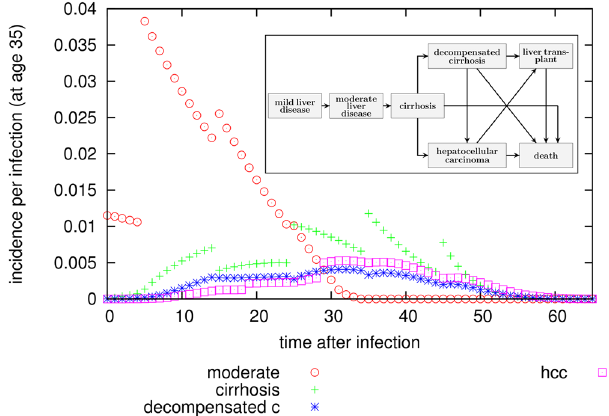
Figure 6. Probability for incidence of progression states as a function of time after infection. These probabilities are calculated separately for each infection age (in this figure this is 35 years of age), since we use age-dependent disease progression values 40 as well as mortality data 39 . From these values, cumulative incidences as a time after infection can be calculated, and from that the average number of life years lost (again as a function of time of infection), which allows to calculate an estimate on the number of life-years saved at system-level via comparison of two scenarios. The lines of points are discontinuous because disease progression parameters are age-dependent and sometimes differ strongly between